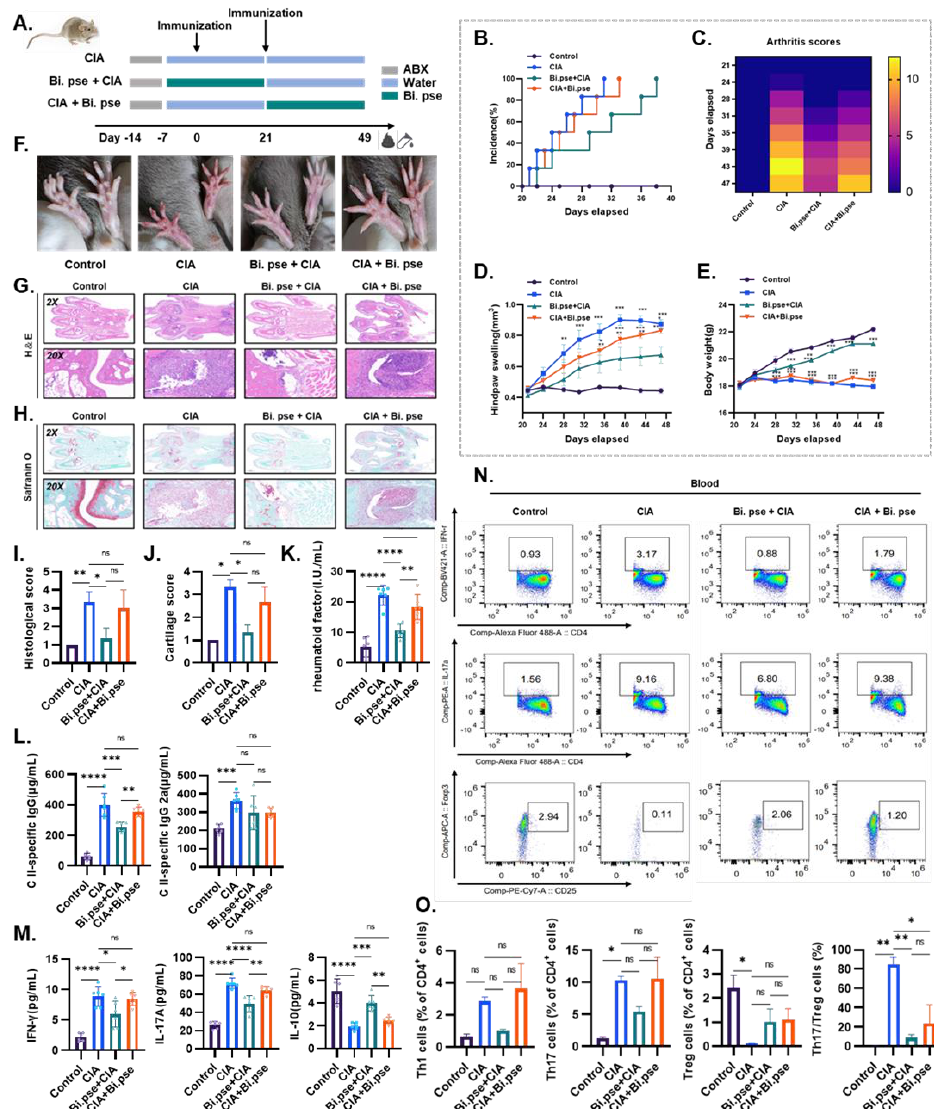
Figure 3. Effect of B. pseudocatenulatum on the onset and progression of arthritis in the CIA mouse model. ( A ) Flow chart showing the experimental treatment design. ( B – E ) Effects of B. pseudocatenulatum on CIA incidence, arthritis clinical scores, hind paw swelling, and body weight. Values are presented as means ± SEM. A two-way ANOVA was used to compare values among multiple groups. ( F ) Images of paws in each group before sacrifice. ( G , H ) H&E and Safranin O staining of mice paws to determine joint pathology and cartilage destruction (Scale bars set at 50 and 500 µ m). ( I , J ) Evaluation of joint pathology and cartilage of mice in each group. Values are presented as means ± SD. A one-way ANOVA was used to compare values among multiple groups. ( K ) Levels of arthritis markers (RF) in mice serum were determined by ELISA. ( L ) The concentrations of anti-CII IgG and anti-CII IgG2a in mice serum were determined by ELISA. ( M ) The concentrations of pro-inflammatory factors IFN- γ and IL-17A, and the anti-inflammatory factors IL-10 in mice serum were determined by ELISA. ( N , O ) FCM analysis of the percentage of Th1 (CD4 + IFN- γ +), Th17 (CD4 + IL-17A +), Treg (CD4+CD25+foxp3+) cells, and ratio of Treg/Th17 in blood of mice. Values are presented as means ± SEM. One-way ANOVA and post- hoc Dunnett’s test were performed between multiple groups. Significant results are indicated as: * p < 0.05, ** p < 0.01, *** p < 0.001, **** p < 0.001, ns, non-significant.